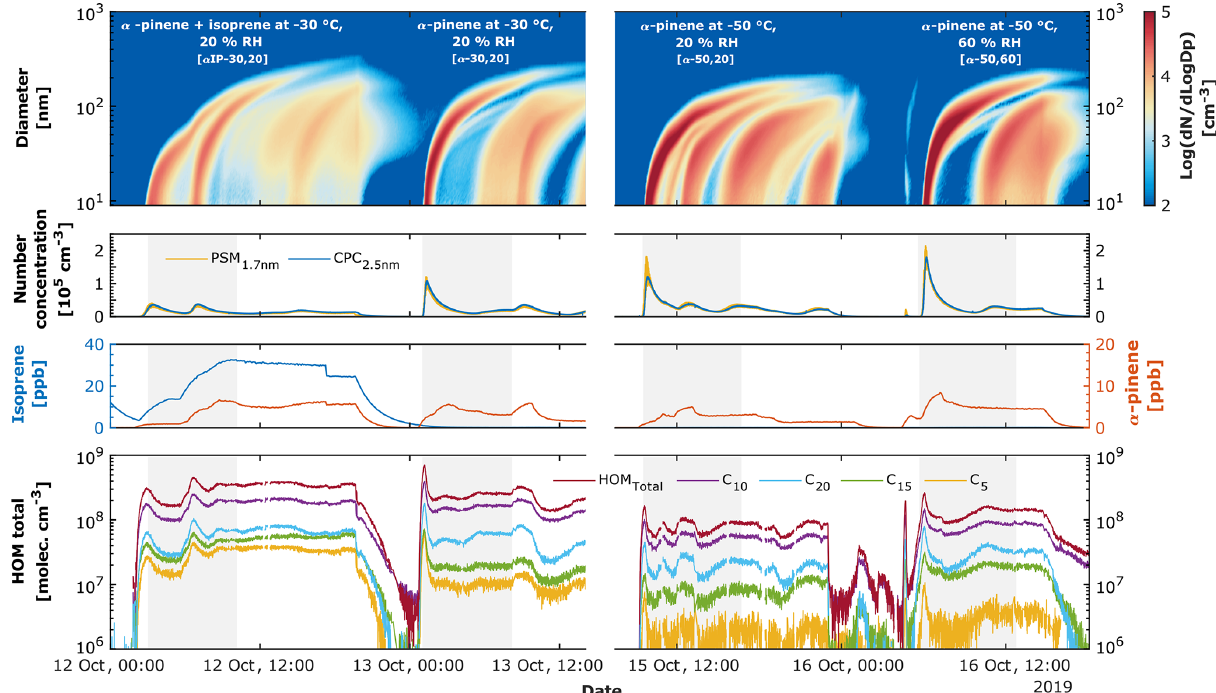
Figure 1. Experimental overview for pure biogenic new particle formation. First panel: particle size distribution for four different experi- ments: α -pinene + isoprene at − 30 ◦ C and 20% RH ( α IP-30,20), α -pinene at − 30 ◦ C and 20% RH ( α -30,20), α -pinene at − 50 ◦ C and 20% RH ( α -50,20), and α -pinene at − 50 ◦ C and 60% RH ( α -50,60). The color scale represents the log 10 of the normalized particle concentration in cubic centimeters (cm − 3 ). Second panel: particle number concentration in cm − 3 measured by the PSM with a cutoff diameter of 1.7nm and CPC 2.5nm. Third panel: mixing ratio in parts per billion by volume (ppbv) for the biogenic precursor gases, isoprene, and α -pinene. Fourth panel: evolution of total HOM concentration in molecules per cubic centimeter (molec.cm − 3 ), measured in the gas phase by the nitrate CI-APi-TOF mass spectrometer. The HOM total is defined as the sum of C 5 , C 10 , C 15 , and C 20 carbon classes, which are shown as well. Ozone level is not shown though remains stable over the whole period at ∼ 100ppbv. The shaded areas refer to the time when the particles were collected using the